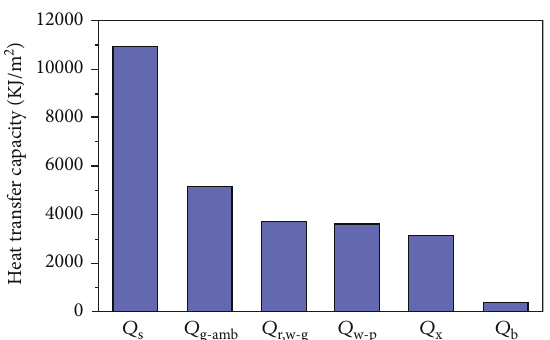
Figure 8: Heat transfer between di ff erent components of chimney during the day.